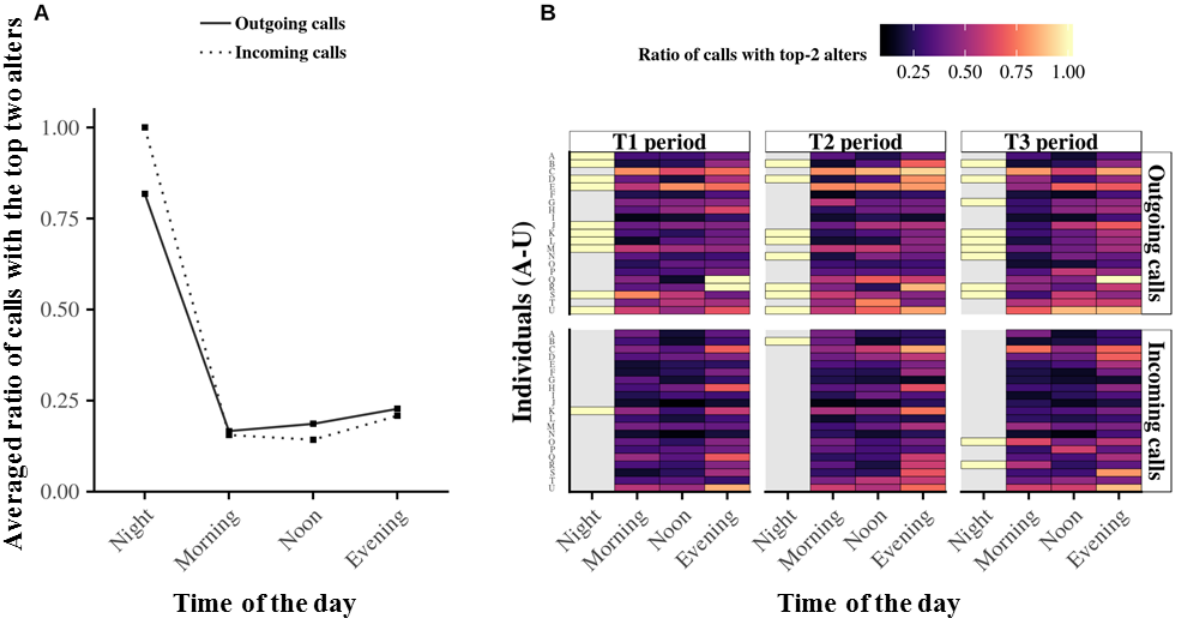
Figure 8. Fraction of telephone calls with the top two alters at the individual level. Panel A shows the average fraction of calls with the top two alters for both outgoing (black curve) and incoming (dotted curve) telephone calls. Panel B summarizes on a heat map the fraction of telephone calls with the top two alters for all 21 egos. A light (dark) color indicates a high (low) fraction, and gray indicates missing values. Although individuals have their own top two alter specificity during the day, the average relative entropy of the population seems similar, except at nighttime when too much data are missing to draw significant